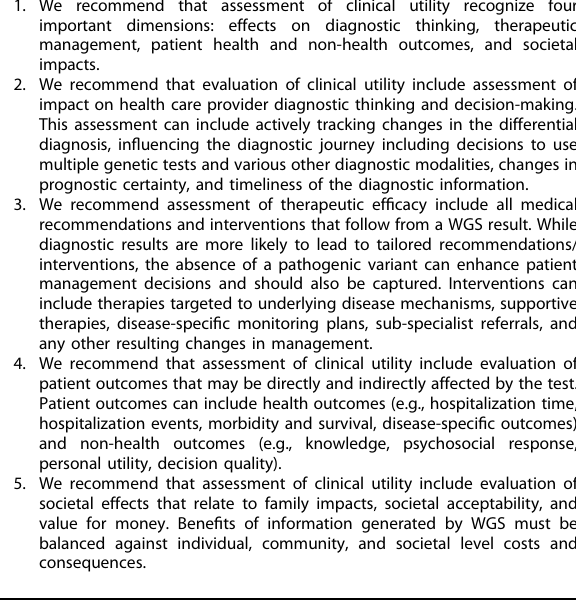
Box 1 Recommendations for evaluating clinical utility of genomic